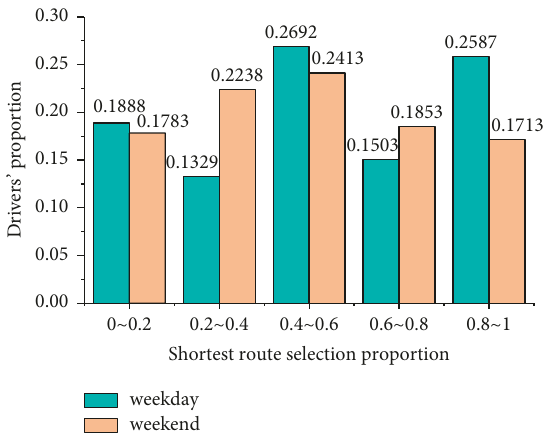
Figure 12: Interval distribution of the shortest path selection for the same